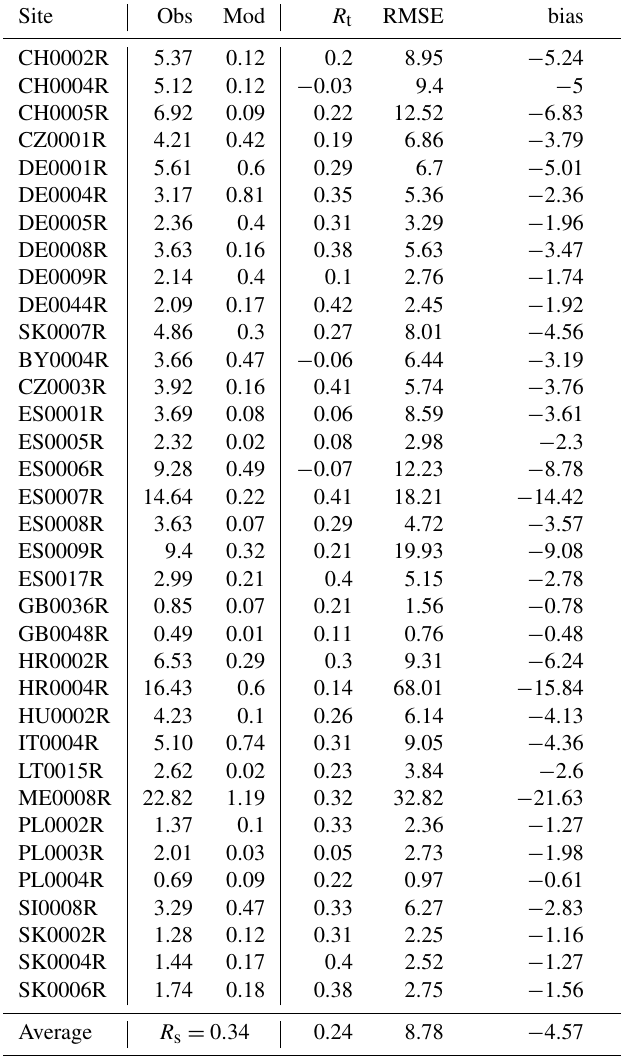
Table 7. Comparisons between observations (EMEP) and model (CHIMERE) for the weekly mean deposition fluxes of nssCA 2 + (milligrams per square metre). Results are presented for the whole year 2012 and for the temporal correlation ( R t ), the root mean squared error (RMSE) and the bias (model minus observations). The last line “average” represents the spatial correlation R s between the mean observed and modelled values and the mean averaged val- ues of temporal correlation, RMSE and bias.